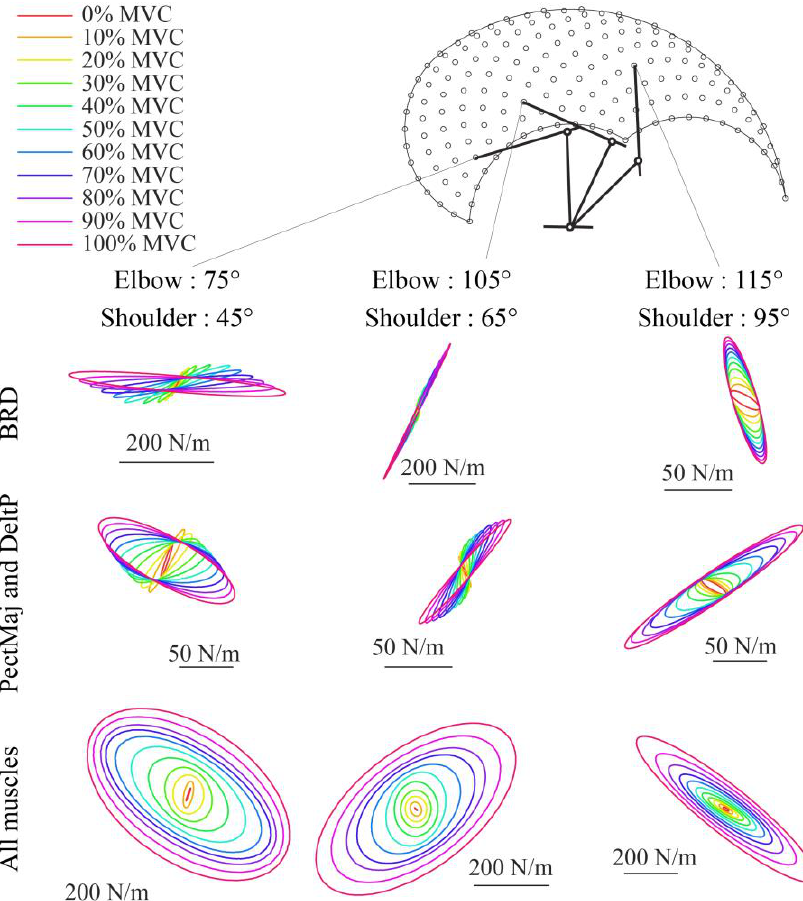
Figure 9. Examples of endpoint stiffness ellipses calculated for different arm configurations and muscle activations from the musculotendon simulation. In the first row, only the BRD muscle is activated at different levels, while all the other muscles have a zero activation. In the second row, both the PectMaj and the DeltP are activated with the same value, while all the other muscles have a zero activation. In the third row, all the muscles are activated with the same activation. Different values of activations are coded with different colors.